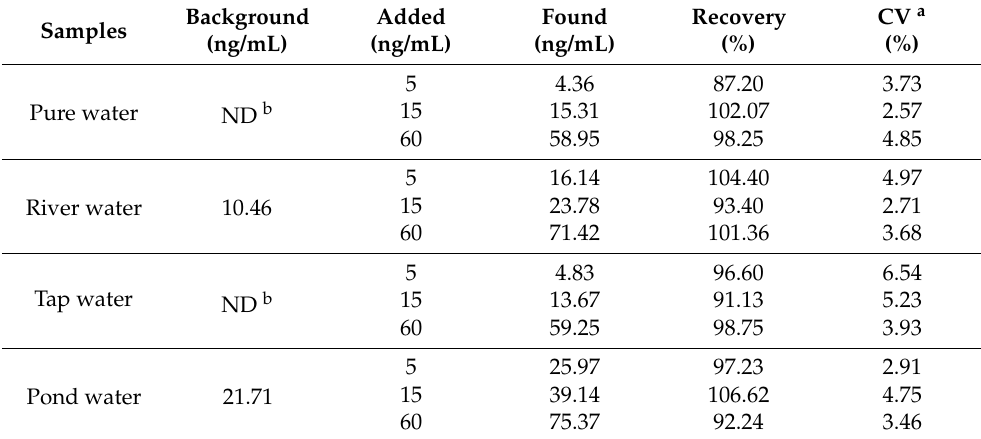
Table 1. Analysis of DBP-spiked samples using this method ( n =